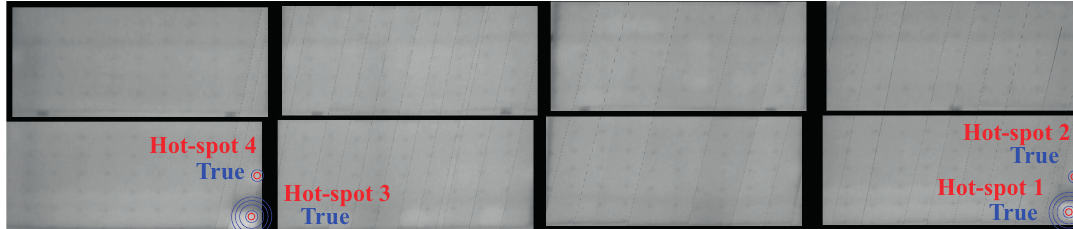
Figure 10. Results of the hot-spot detection: The system searches for two hot-spots over the analysed photovoltaic module. The camera is positioned facing the PV-structure at 3 m.